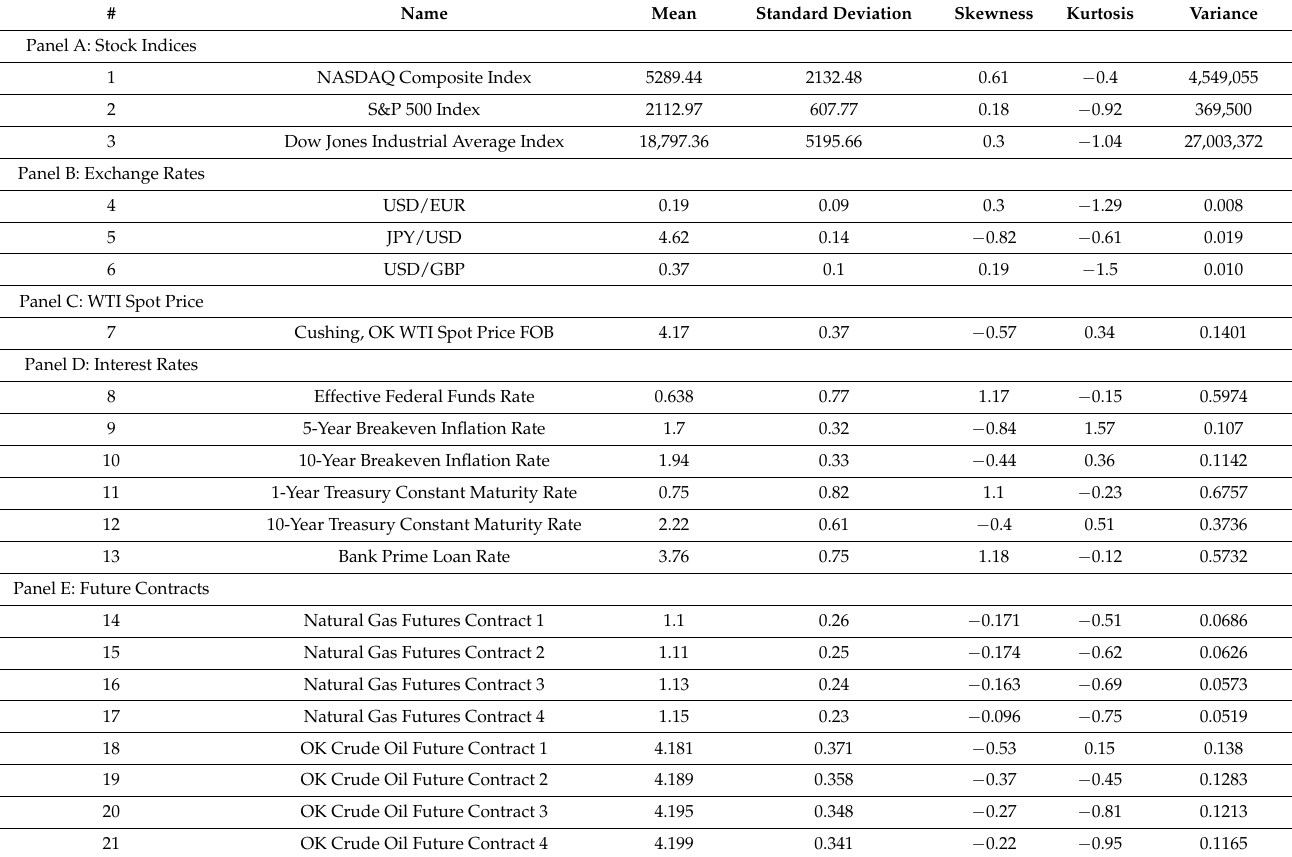
Figure 3. A three-fold cross validation for a given set of model parameter values. Each fold serves as a test sample, while the remaining folds are used to train the model. The average prediction accuracy for each set of parameters over the k-folds is used to assess the model [17]. Table 1. List of explanatory variables with mean, standard deviation, skewness, kurtosis, and